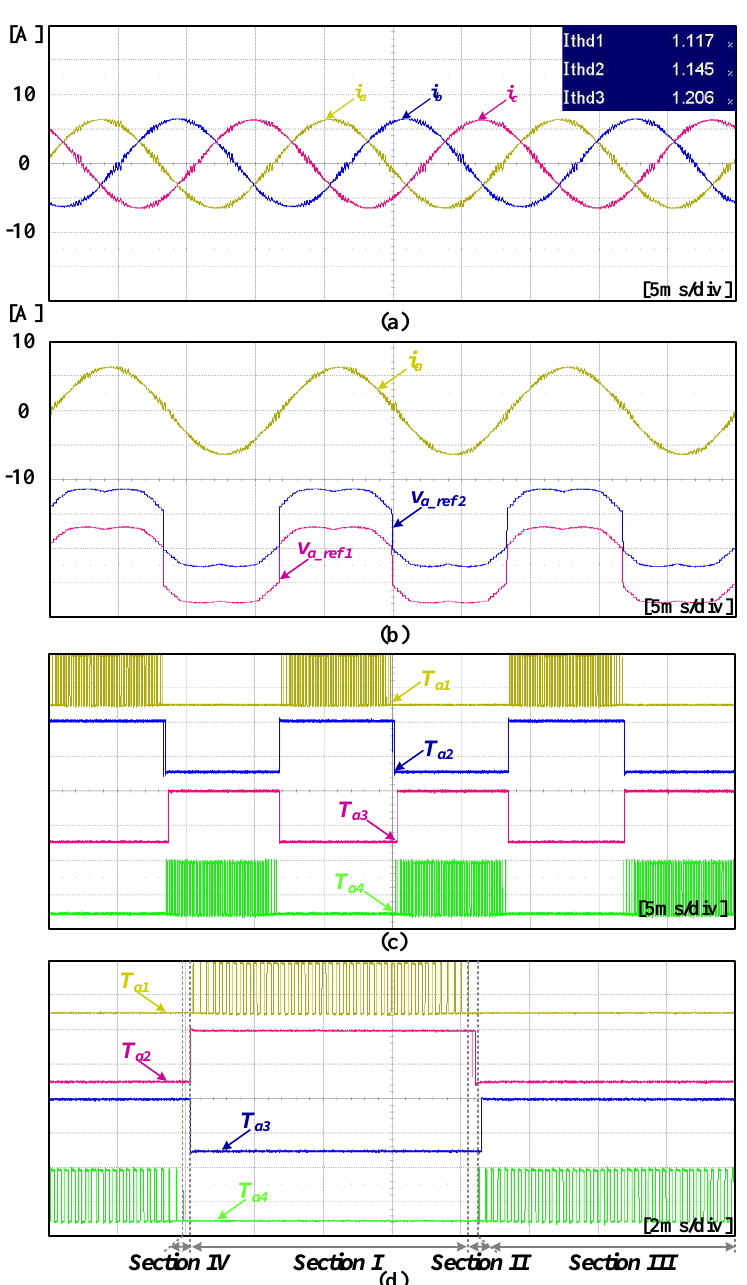
Figure 29. Waveforms of the experimental results using the proposed ZDPWM method with compensation method: ( a ) Each phase current; ( b ) Reference voltage; ( c ) Switching signal (5 ms / div); ( d ) Switching signal (2 ms /